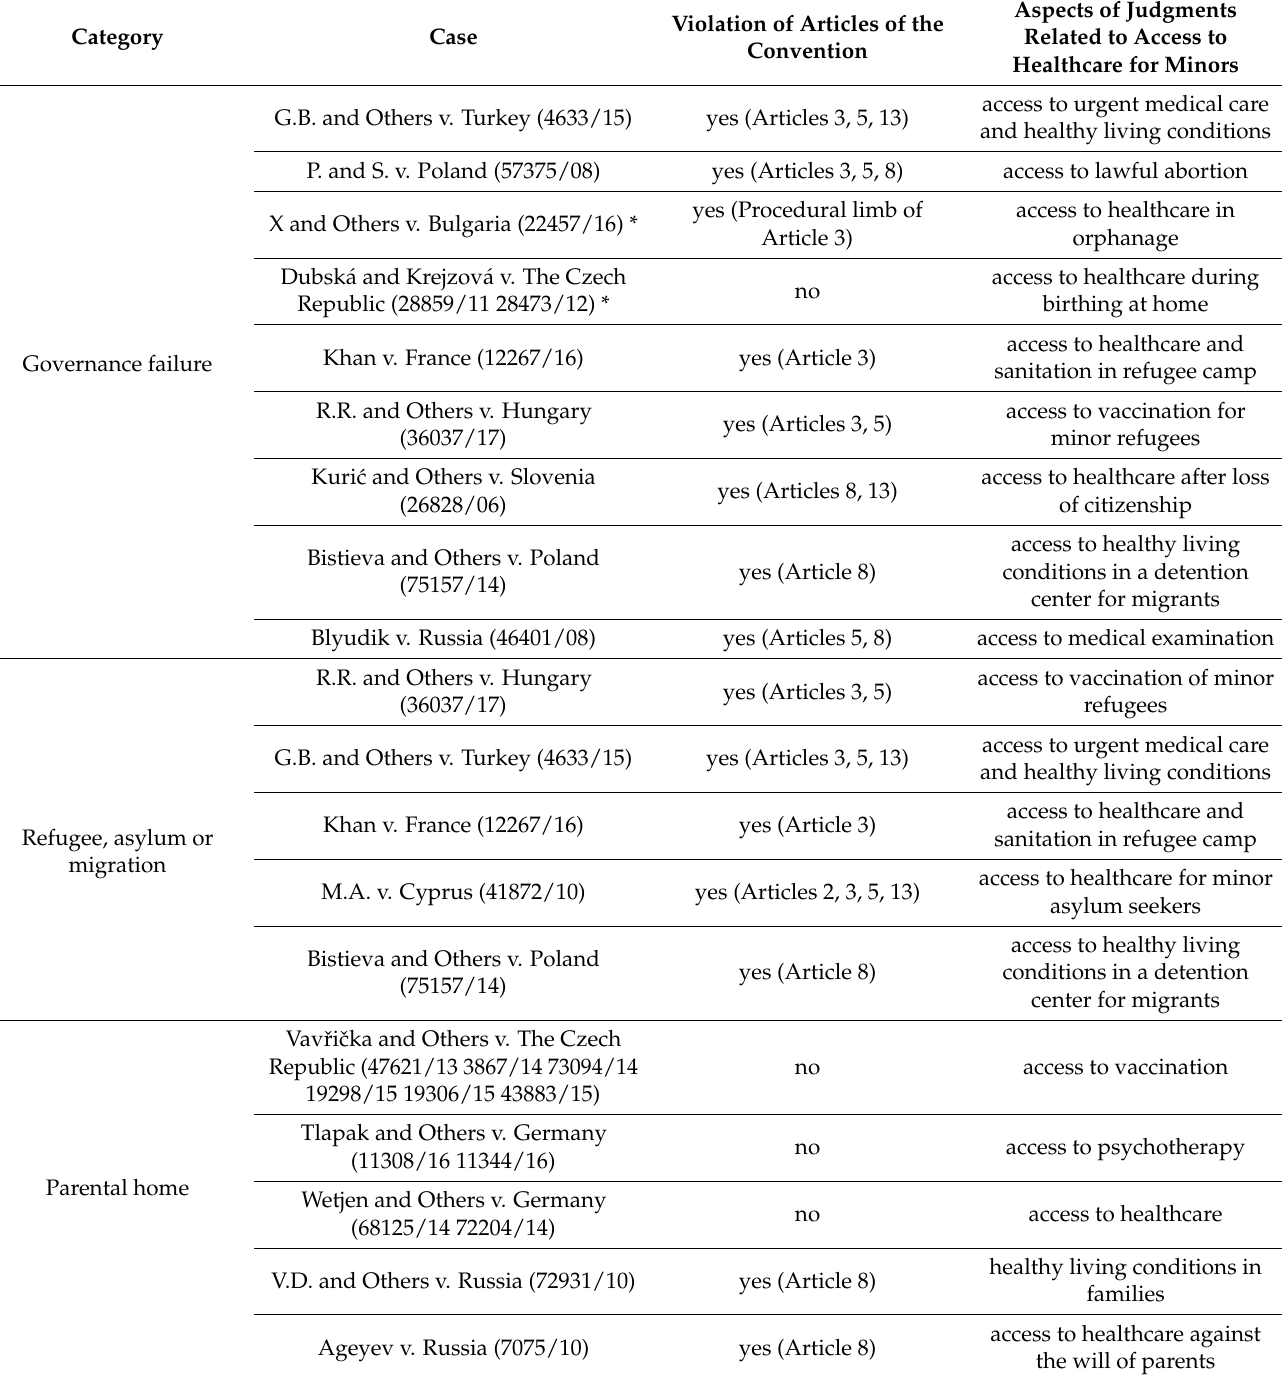
Table 1. Judgments in which access to healthcare for minors played a role ( n =